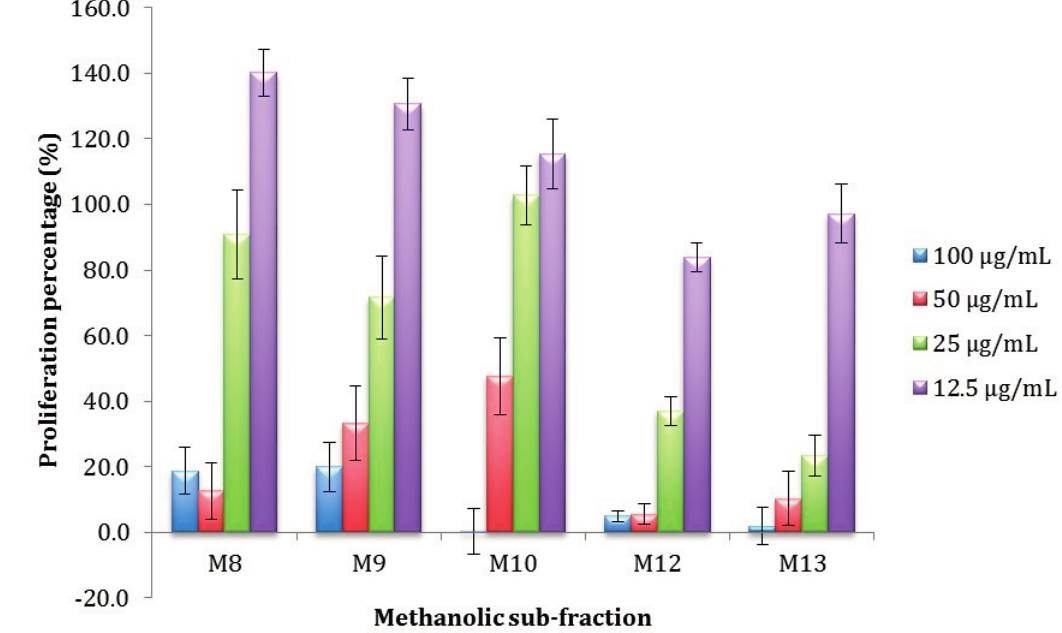
Figure 3. Percentage of proliferation of M12.C3.F6 murine cells exposed to sub-fractions at different lower concentrations. All values represent mean of triplicate determinations ± standard deviation. Control cell cultures were incubated with DMSO (0.5%).